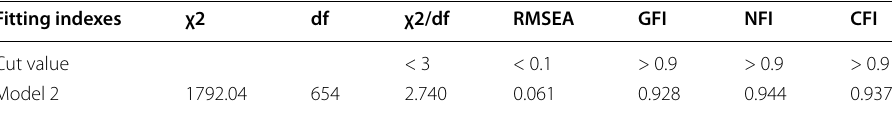
Table 4 Model fit indices (model